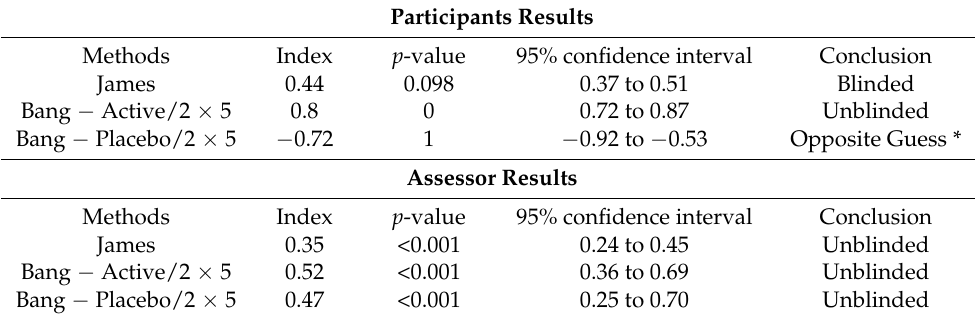
Table 5. Statistical analysis of blinding assessment. * Wishful thinking participants tend to think they are allocated to the active group even if not in